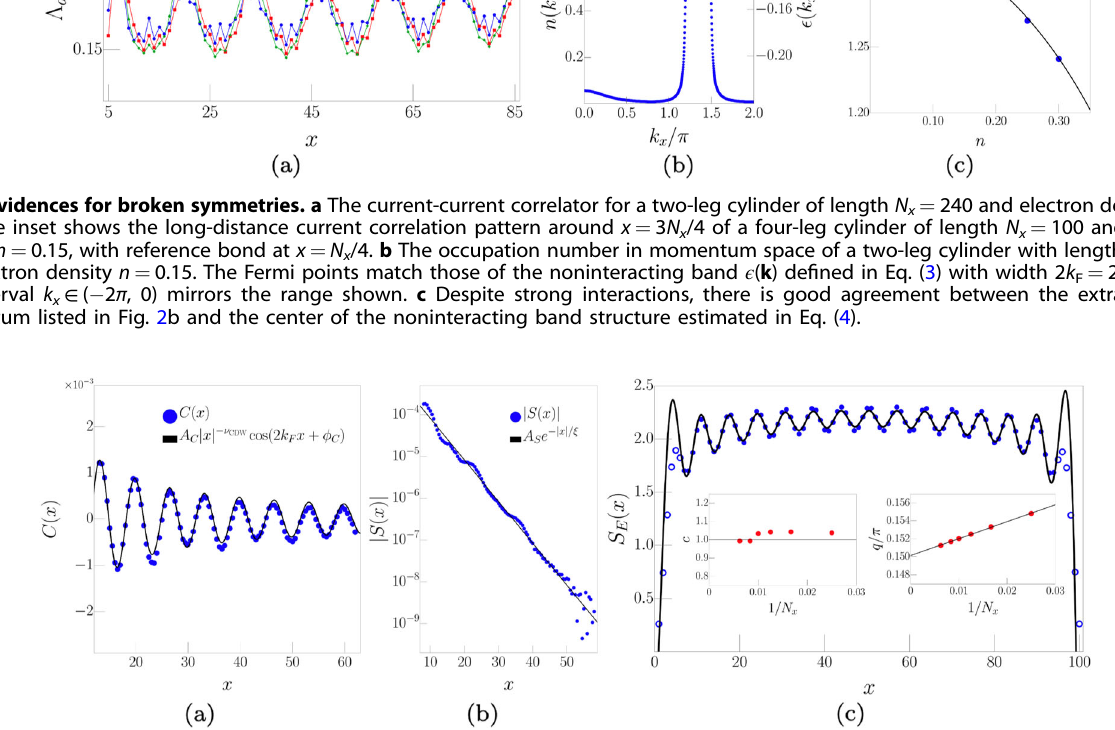
= 240 and n = 0.15 x